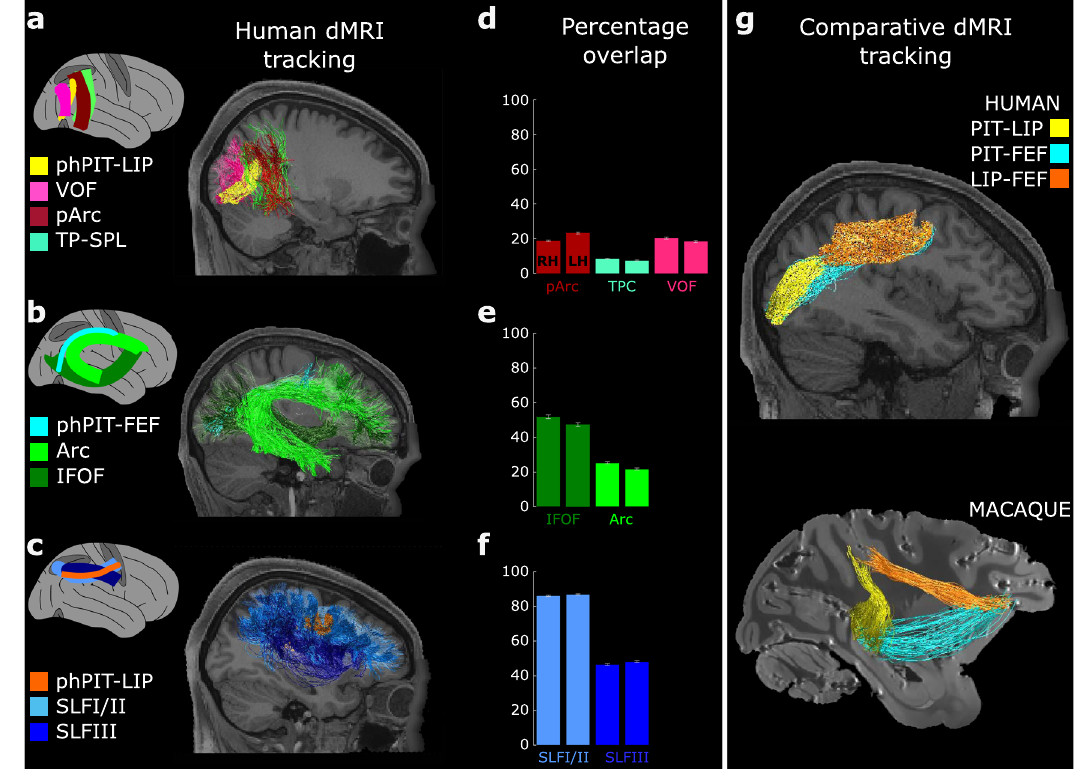
Fig. 7 A sub-portion of pArc, Arc, and SLF support the endogenous attention network. a Sagittal view of the VOF (pink), pArc (dark red), TP – SPL (green), and phPIT-to-LIP (yellow) connections of subject 101106. b Sagittal view of the Arc (light green), IFOF (dark green), and phPIT – FEF (cyan) connectivity of subject 101106. c Sagittal view of SLF (dark and light blue) and LIP – FEF (orange) connectivity of subject 101106. d – f Quantitative overlap, i.e., proportion of functionally de fi ned attentional tracts overlapping with hypothesized anatomical pathways. Data are expressed as mean across 263 subjects; left bars for each tract represent the average across the left hemisphere, right bars across the right. g Sagittal view of the human and macaque showing the comparative anatomy of the dorso-ventral endogenous attention network as de fi ned in ref. 19 . FEF frontal eye fi eld, LIP lateral intra parietal area, phPIT putative human posterior infero- temporal area, Arc Arcuate Fasciculus, IFOF Inferior Frontal Occipital Fasciculus, pArc posterior Arcuate Fasciculus, SLF Superior Longitudinal Fasciculus TP – SPL Temporo-Parietal connection to the Superior Temporal Lobule, VOF Vertical Occipital Fasciculus. Source data are provided as a Source Data fi